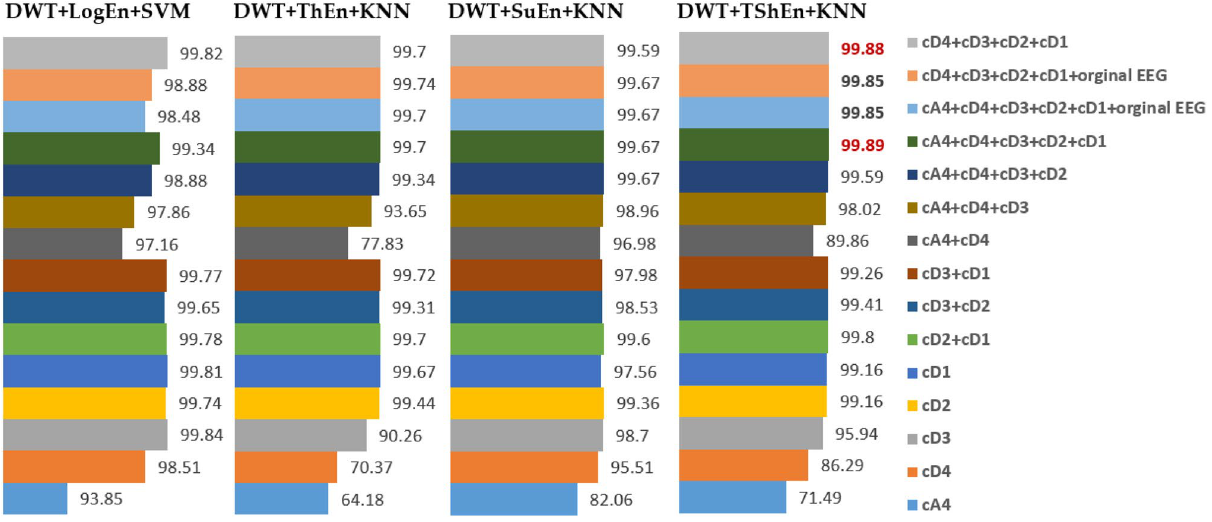
cA4 coefficients are included. Table 6 shows that the features extracted from F region channels are classified with higher accuracy. The P region and C region channels come in second and third place, respectively. Obtain-